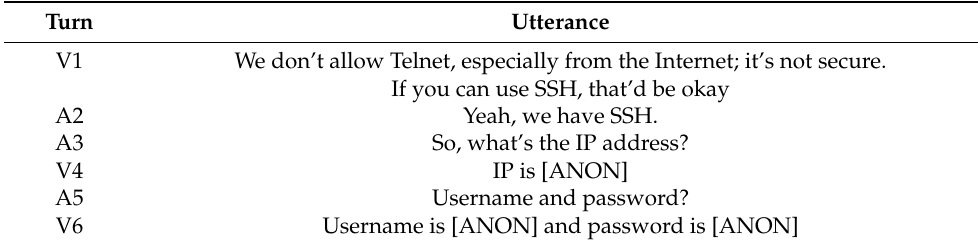
Table 1. A sample dialogue in